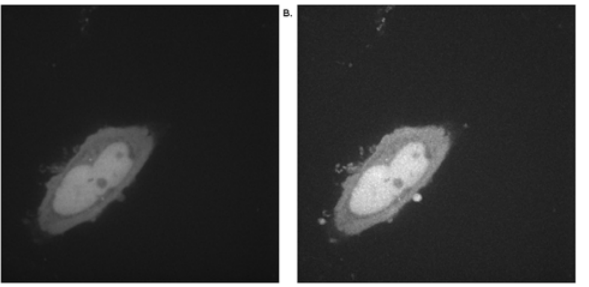
Fig 3. A statistical model of the image sequence. Construction of (A) the mean image M and (B) the standard deviation image S of a time series of a single HeLa cell transiently expressing photo-converted